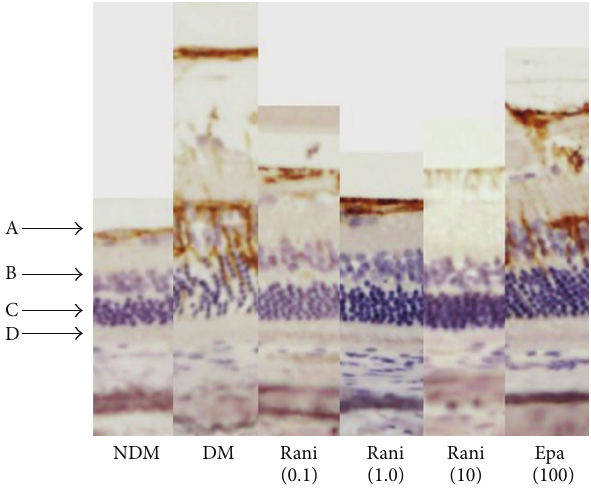
Figure 6: Comparison of retinas in each group. A: ILM; B: INL; C: outer nuclear layer; D: retinal pigment epithelium. NDM: normal SD rats; DM: untreated SDT rats; rani (0.1): ranirestat-treated SDT rats (0.1mg/kg/day); rani (1.0): ranirestat- treated SDT rats (1.0mg/kg/day); rani (10): ranirestat-treated SDT rats (10mg/kg/day); epa (100): epalrestat-treated SDT rats